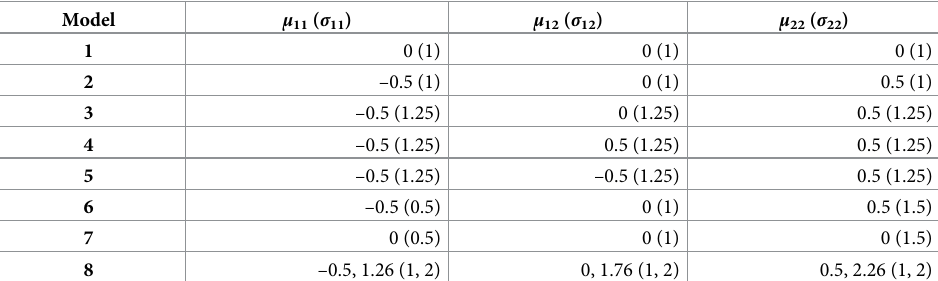
Table 1. Baseline simulation generating